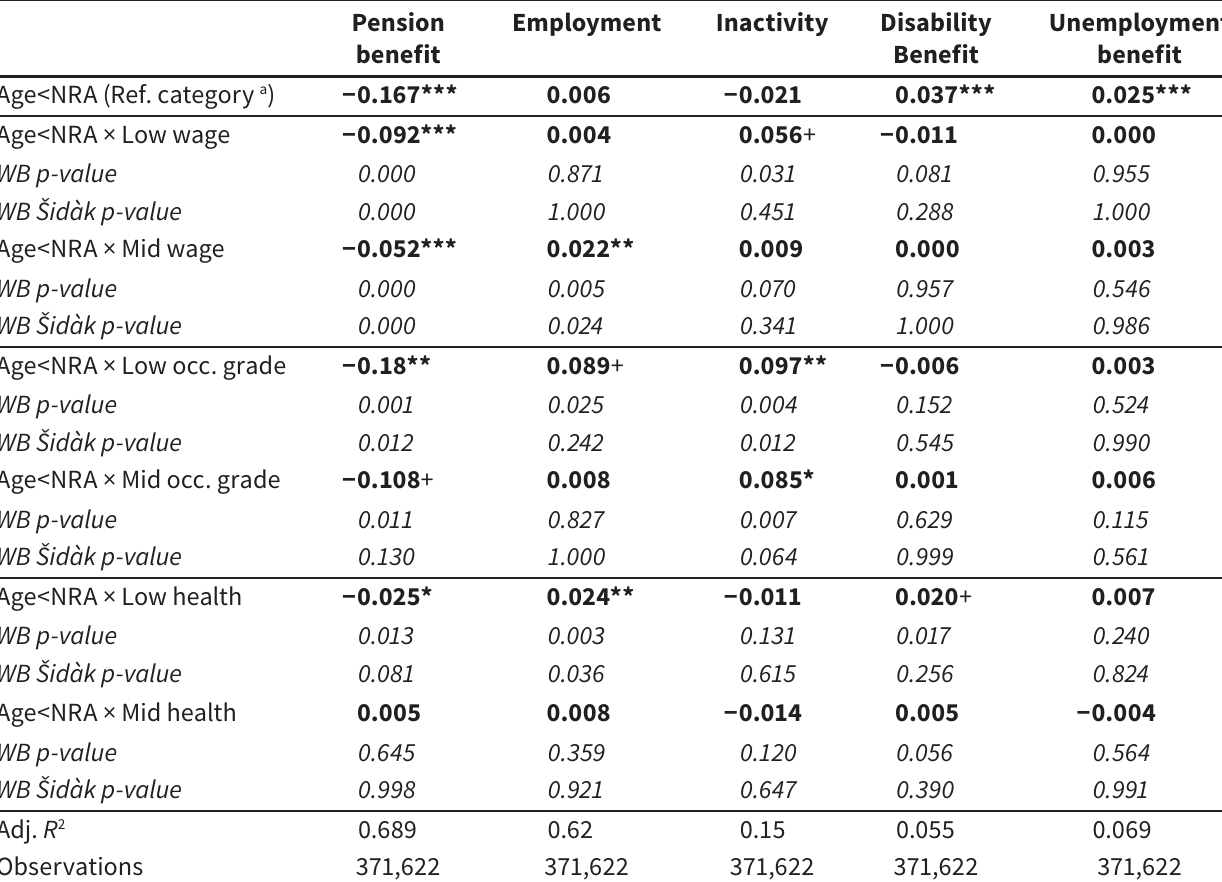
Heterogeneous effect of rising the NRA: fully interacted analysis Pension Employment Inactivity Disability benefit